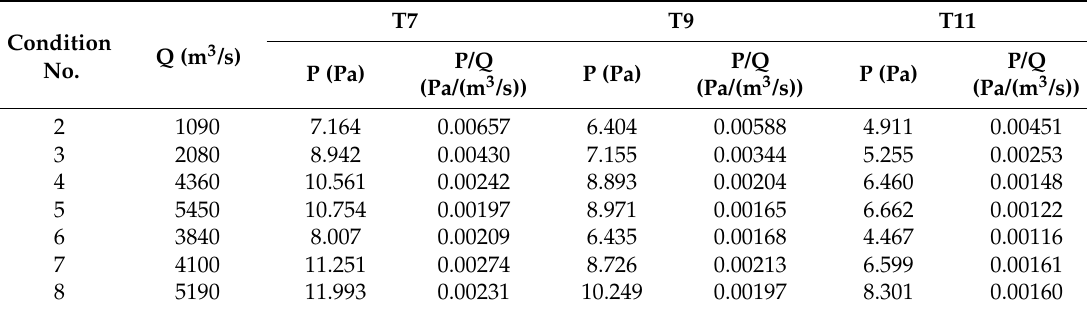
Table 2. Correlation between the LFN intensity, P/Q and